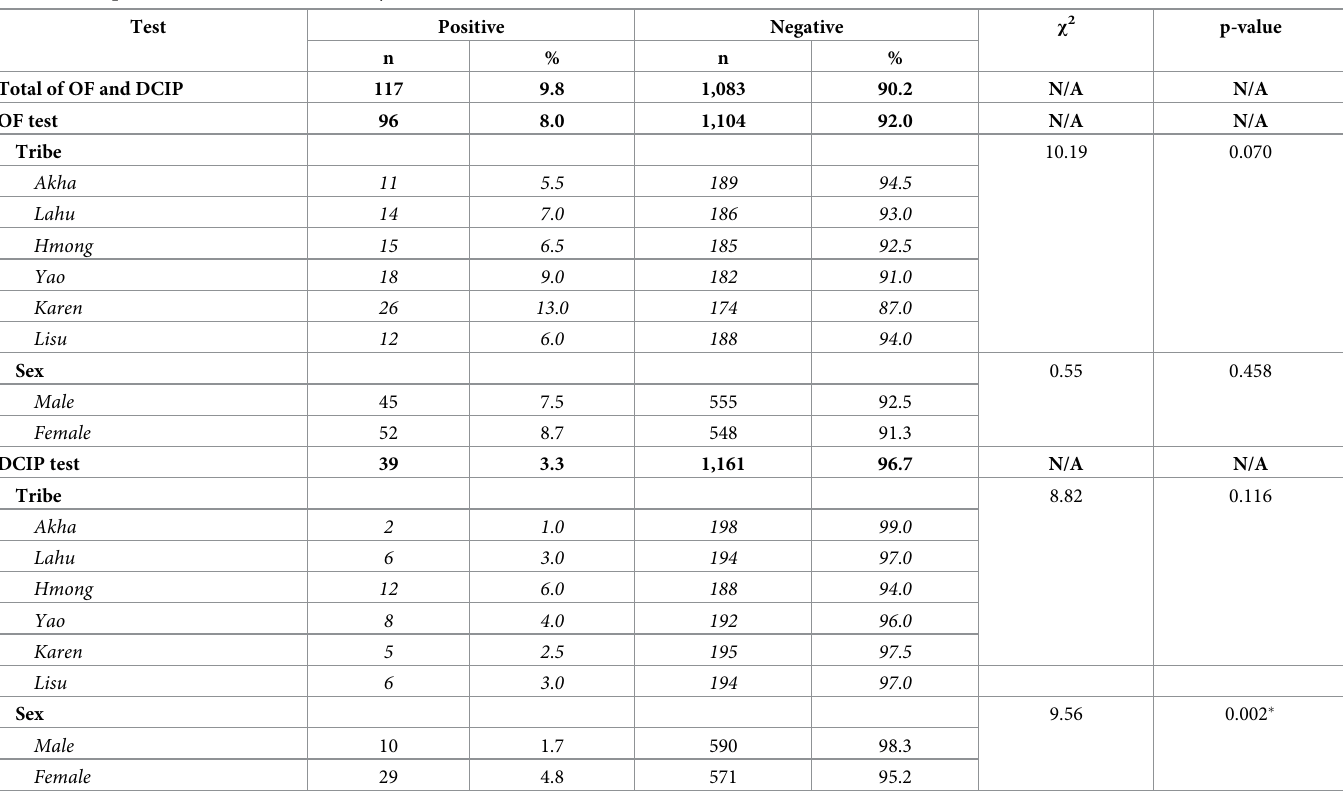
Table 4. Comparisons of OF and DCIP tests by tribe and